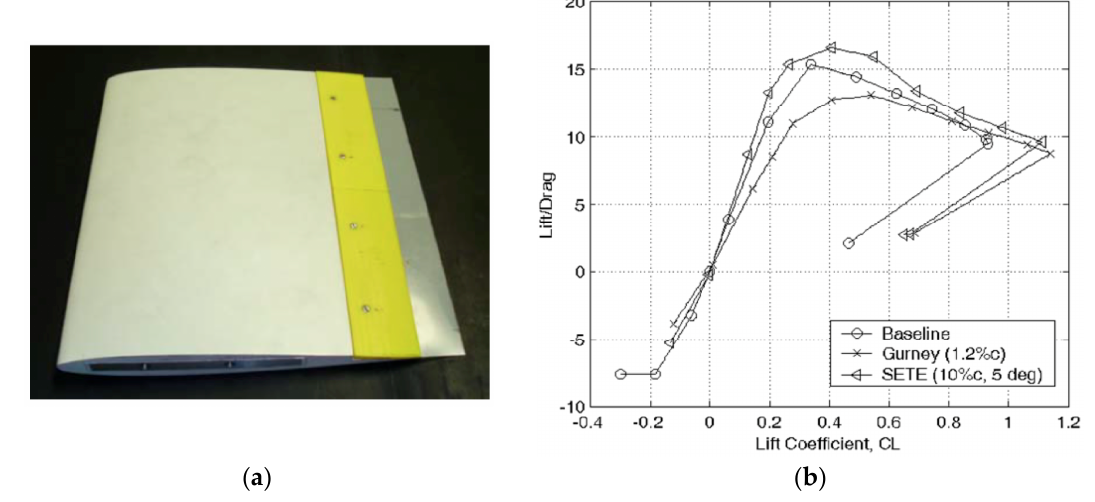
Figure 2. ( a ) NACA 0012 wing with static extended trailing edge (TE). ( b ) Variation of the aerodynamic efficiency with the coefficient of lift for baseline, Gurney and static extended trailing edge (SETE) configurations. The SETE configuration yielded better aerodynamic efficiency than the Gurney flap (adapted from Lui et al.